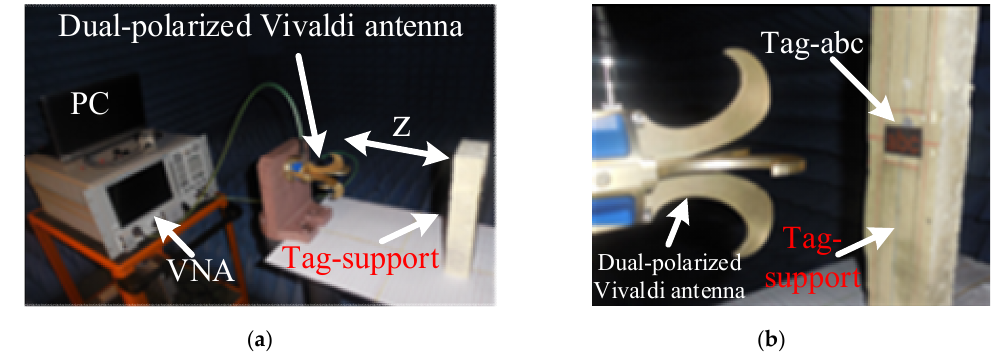
Figure 23. Photographs of measurement in anechoic chamber: ( a ) Measurement setup; ( b ) Tag-abc under measurements.